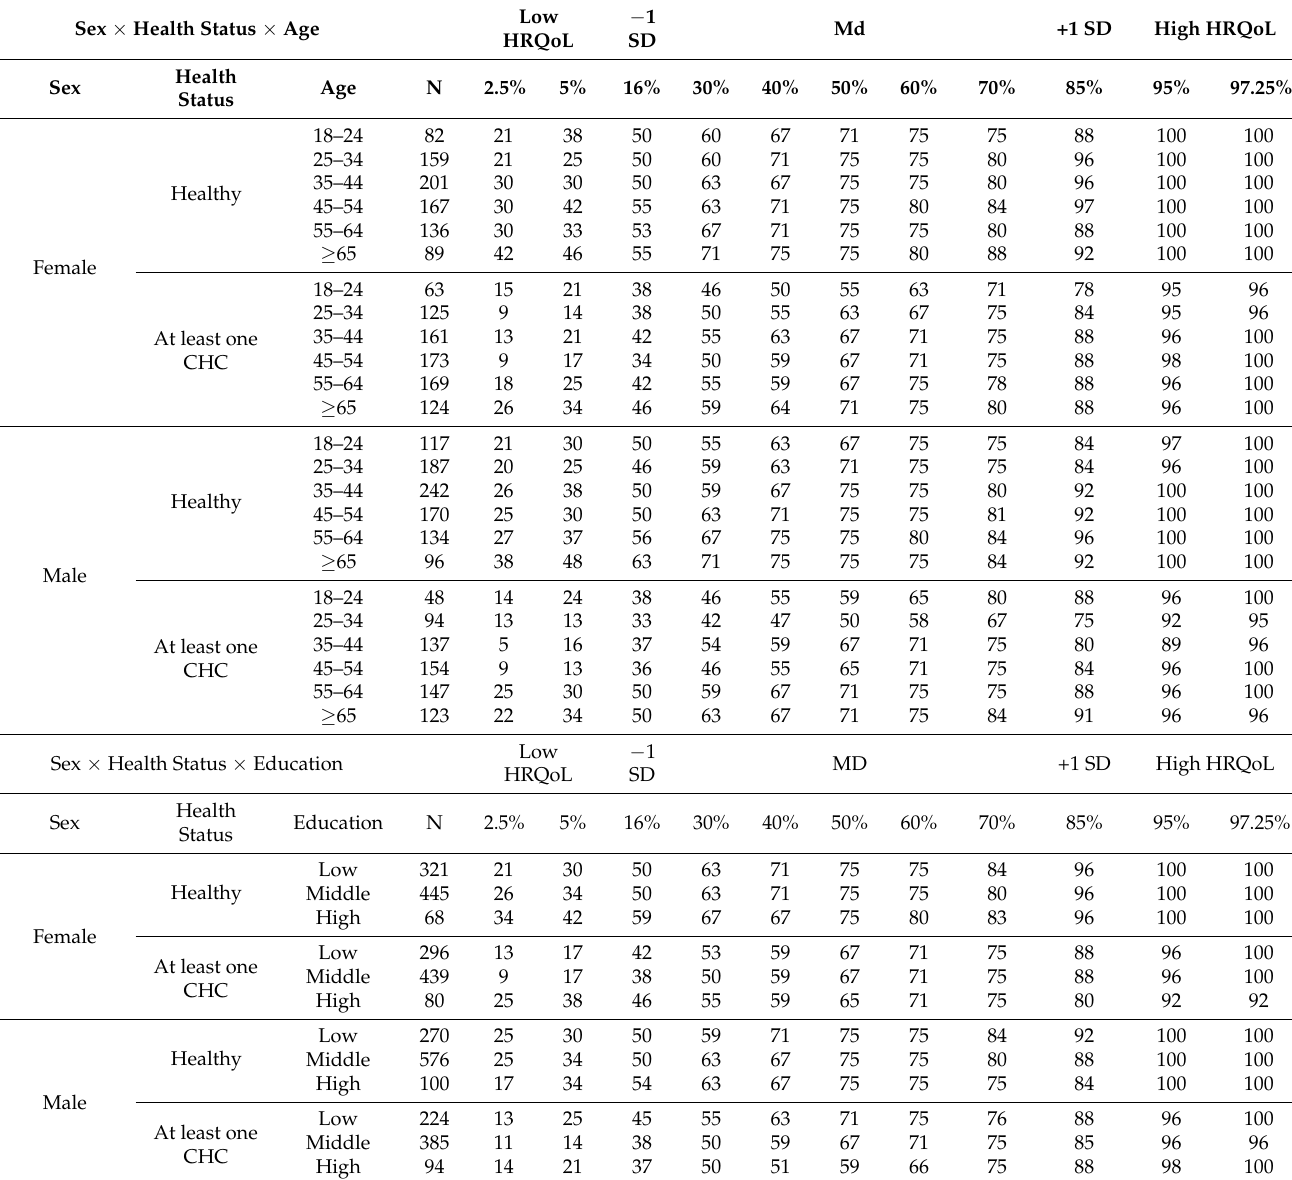
Table A7. Reference values for the QOLIBRI Social Relationships scale obtained from the general population sample in Italy stratified by sex, health status, age, and